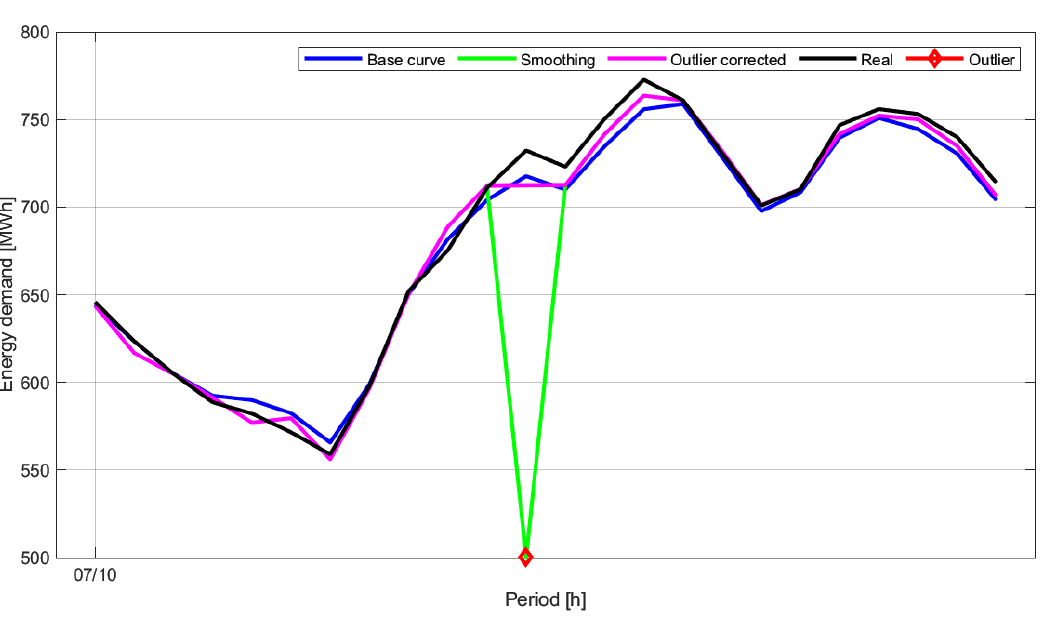
Figure 16. Implementation of the extreme value suppressor for an ordinary day of the Market 1.